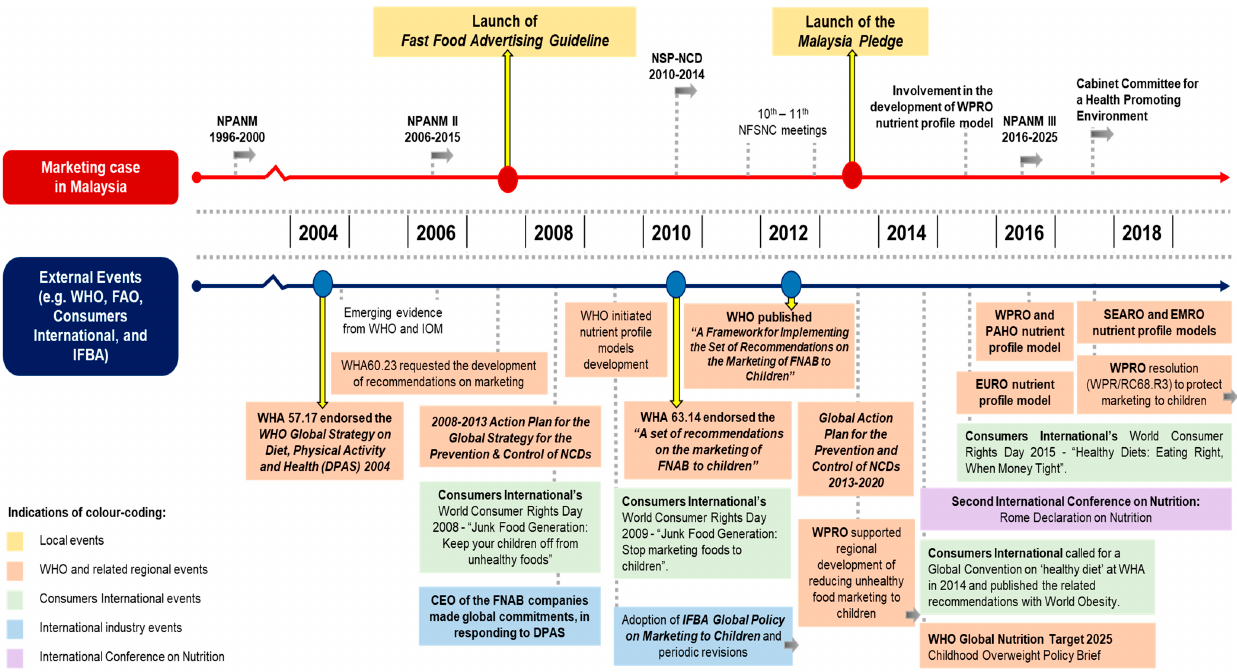
Figure 1. Historical mapping of food marketing policy processes in Malaysia. Abbreviations: CEO = Chief Executive Officer; DPAS = WHO Global Strategy on Diet, Physical Activity and Health; EMRO = WHO Regional Office for the Eastern Mediterranean; EURO = WHO Regional Office for Europe; FNAB = food and non-alcoholic beverages; IFBA = International Food & Beverage Alliance; IOM = Institute of Medicine; NCDs = non-communicable diseases; NFSNC = National Food Safety and Nutrition Council; NPANM = National Plan of Action for Nutrition of Malaysia; NSP-NCD = National Strategic Plan for Non-Communicable Diseases; PAHO = Pan American Health Organization; SEARO = WHO Regional Office for South-East Asia; WHA = World Health Assembly; WHO = World Health Organization; WPRO = WHO Regional Office for the Western Pacific.